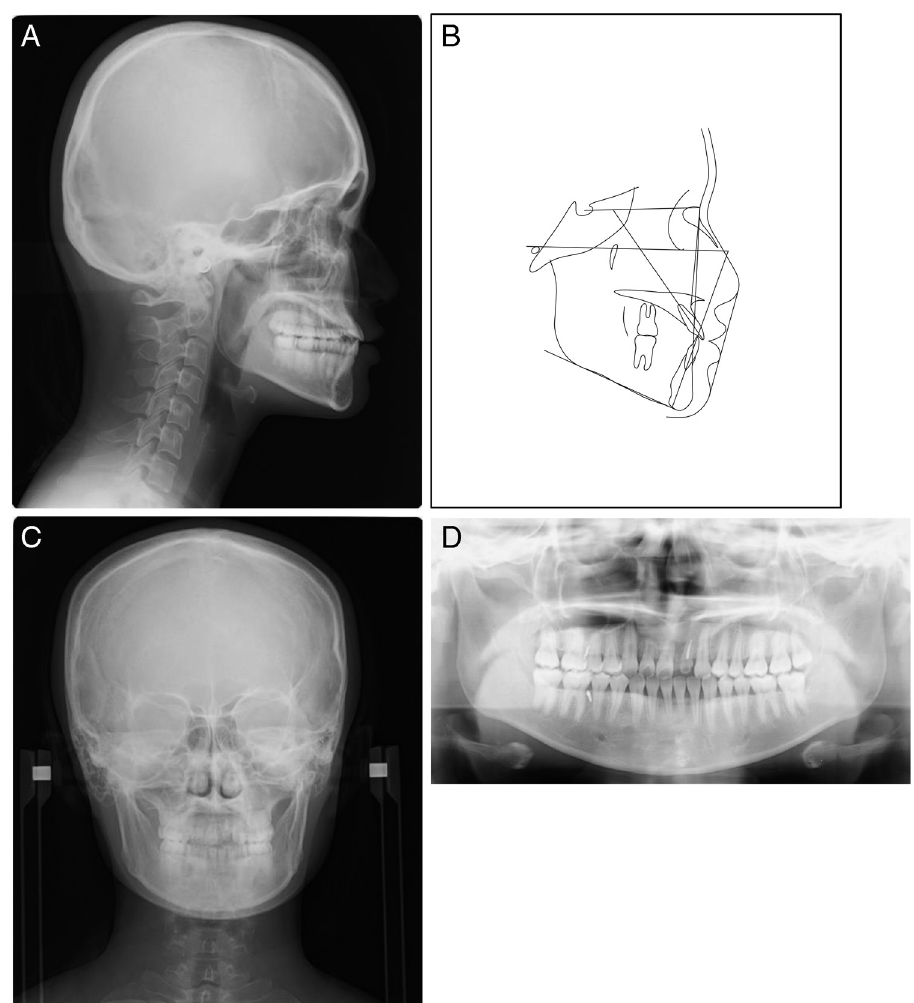
Figure 8. Posttreatment cephalograms, a tracing of lateral cephalogram and a panoramic radiograph. (A) Lateral cephalogram. (B) Tracing. (C) Posteroan- terior cephalogram. (D) Panoramic